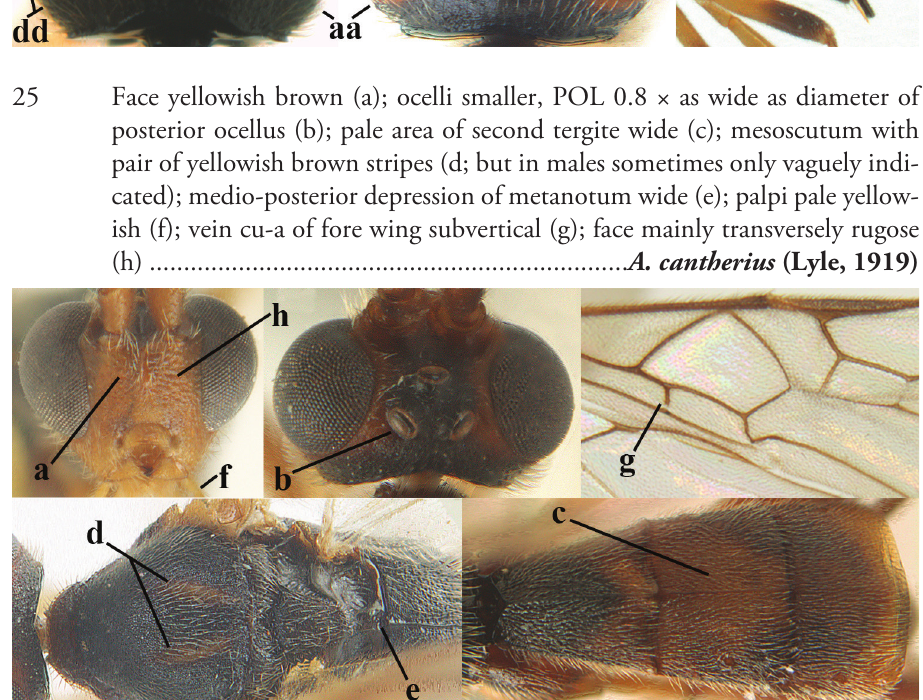
– Face black (aa); ocelli larger, POL 0.6 × as wide as diameter of posterior ocel- lus (bb); pale area of second tergite narrow (cc); mesoscutum entirely black (dd); medio-posterior depression of metanotum rather narrow (ee); palpi mainly dark brown (ff); vein cu-a of fore wing inclivous (gg); face superficially rugulose (hh) ................................................................... A. ryrholmi sp.